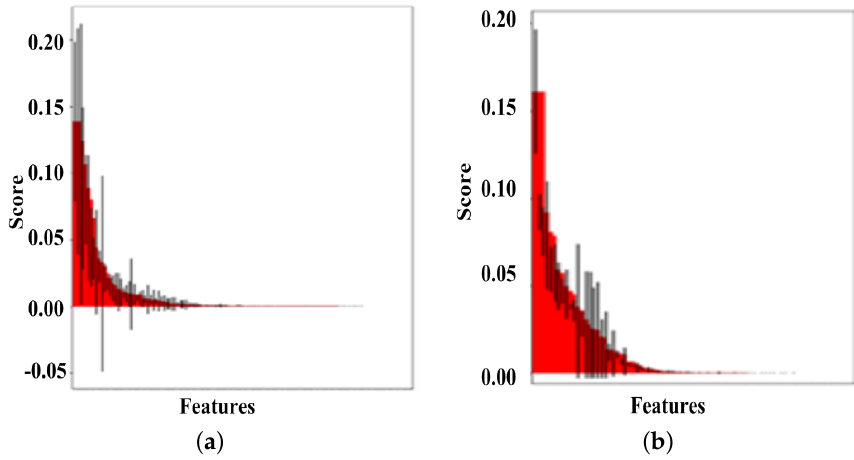
Figure 6. Feature importance for ( a ) random forest and ( b ) neural